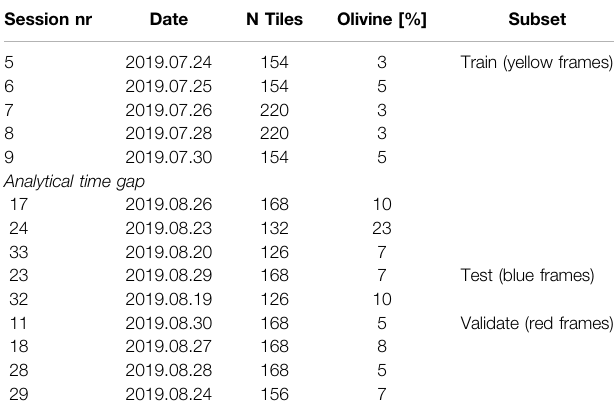
TABLE 1 | Analytical subsets (colour frames in Figure 1 ) used for training, testing and validation. Session nr